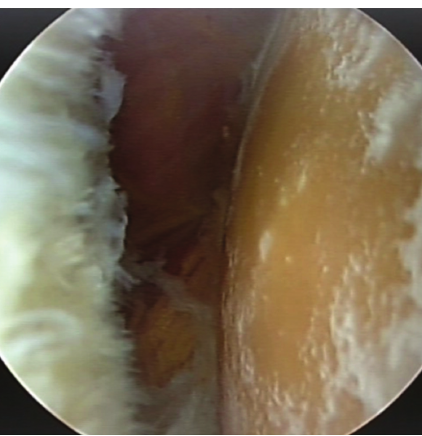
Figure 1: Arthroscopic view of severe osteoarthritis of the right humeral head in a 53-year-old